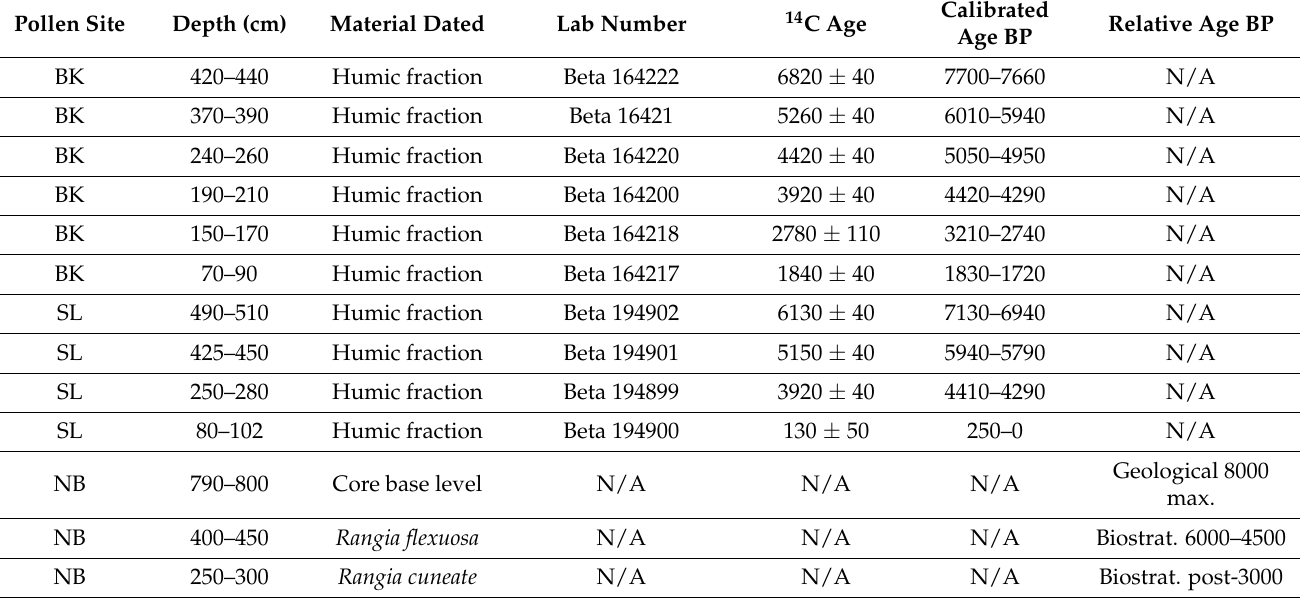
Table 7. Pollen site dating by radiocarbon, geology and biostratigraphy. Materials for dating BK and SL derived from bulk sediments in sediment cores. The dating of the NB site relied on relative biostratigraphic indications of Rangia spp. according to finds in regional archaeological sites and geological dating according to the emergence of base-level conditions at the coring site (delta formation at site sedimentation itself prior to 8000 BP can thus be